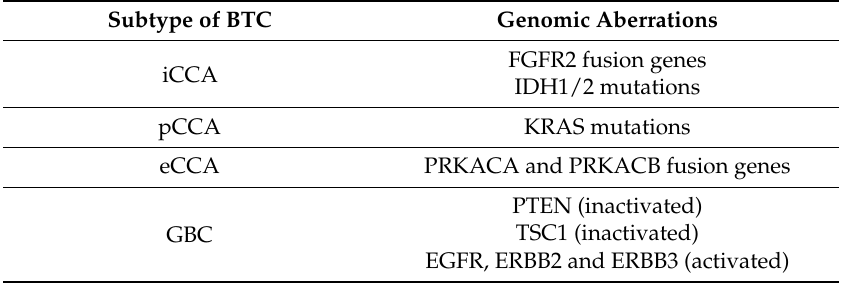
Table 1. Genomic aberrations of biliary tract cancers (BTCs) linked to the angiogenesis and correlated to the location of